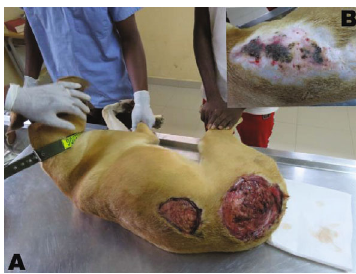
Figure 1: The patient on an examination bench. (a) Two large deep ulcers on the dorsum spanning the thoraco-lumbosacral region with cellulitis. (b) The dorsum of the thorax, after shaving, showing coalescing multifocal purple to black necrotic skin. Table 1: Full blood count of the patient (dog).